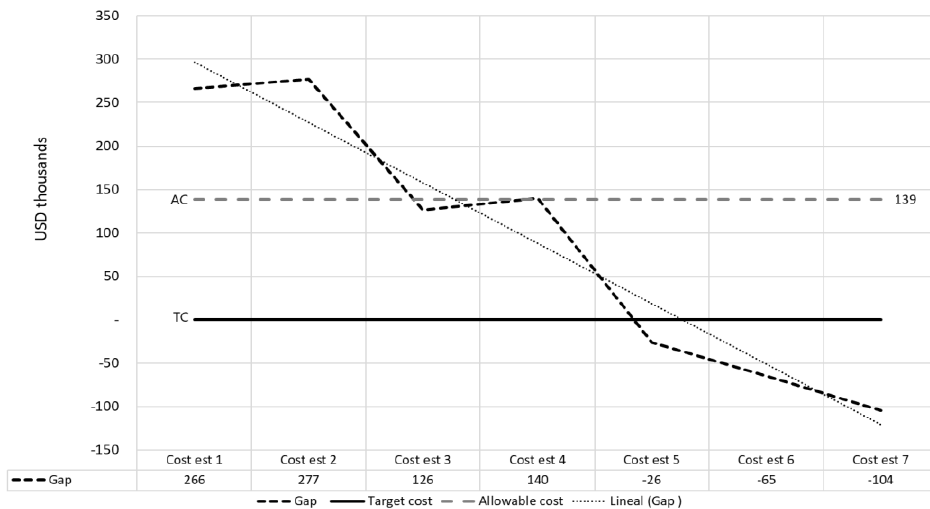
Figure 4. Target costing chart. Cost evolution.